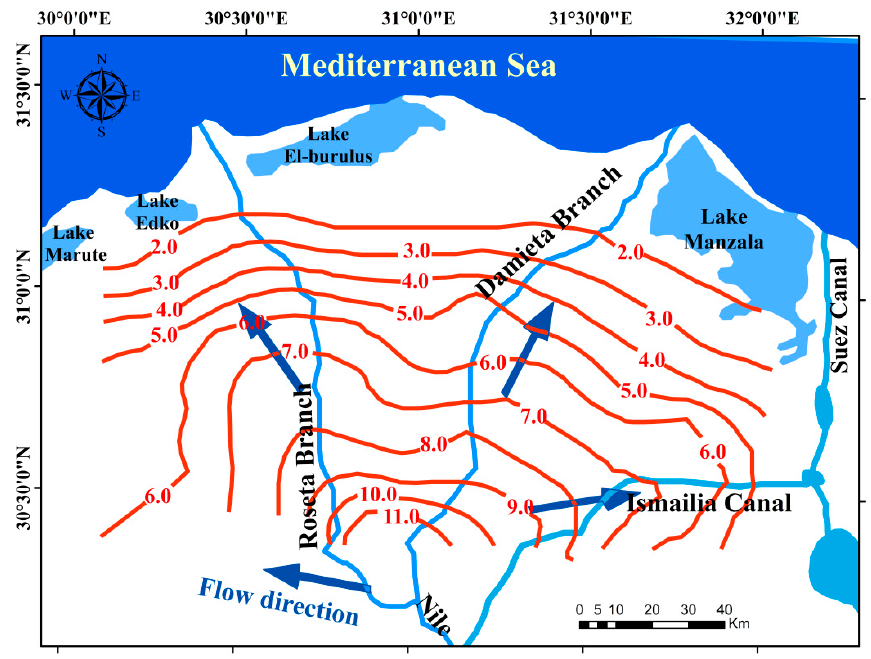
Figure 8. Contour map of the Quaternary aquifers at the Nile Delta [51]. Running the model revealed that the amount of groundwater pumped to the study area is approximately 92.05 Mm 3 /year, as shown in Table 9. Figures 9 and 10 show that the direction of groundwater flow is to the north, heading towards the cities of Shubra Al Khaymah, Al Khusus, Al Khankah, Bilbies, Abu Hammad, and Al Salhiya and to the east towards the cities of Tell El Kebir, El Kasasin, Abou Sweir, Ismailia, West-El Qantara and Fayed. The largest quantity groundwater was pumped to the area in the month of February (during the time of the winter closure). Abu Hammad is the center which benefits the most from groundwater in Al-Sharkia governorate, because it contains about 34 wells [40] and most of the groundwater is pumped to the Ismailia governorate, which contains about 1278 wells and 29553 feddan benefit from [34] (see Figure 9).